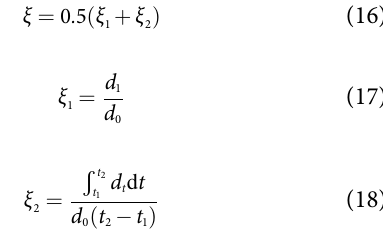
Fig. 15 Federated learning errors of currents’ real parts (x-axis) and imagi- nary parts (y-axis) for microgrid 3’s ( a ) phase , ( b ) phase , and ( c ) phase